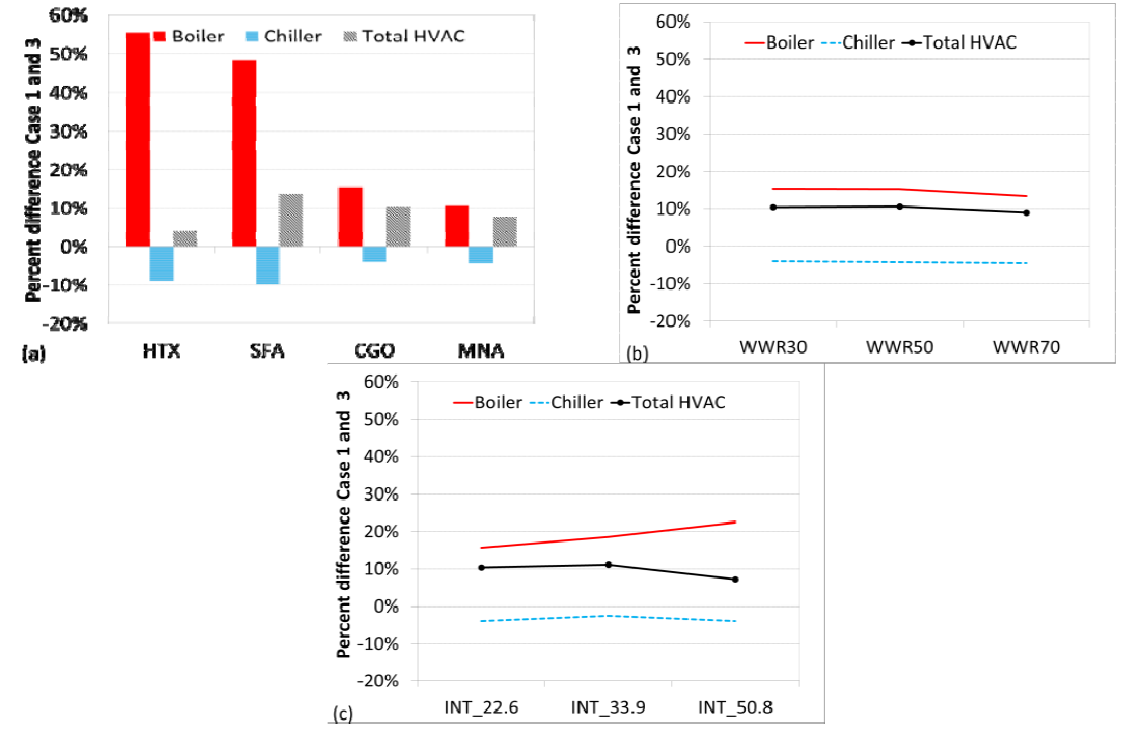
Figure 8. Sensitivity analysis for Case 1 to Case 3 comparison. ( a ) Impact of climatic condition; ( b ) impact of window-to-wall ratio and ( c ) impact of internal load